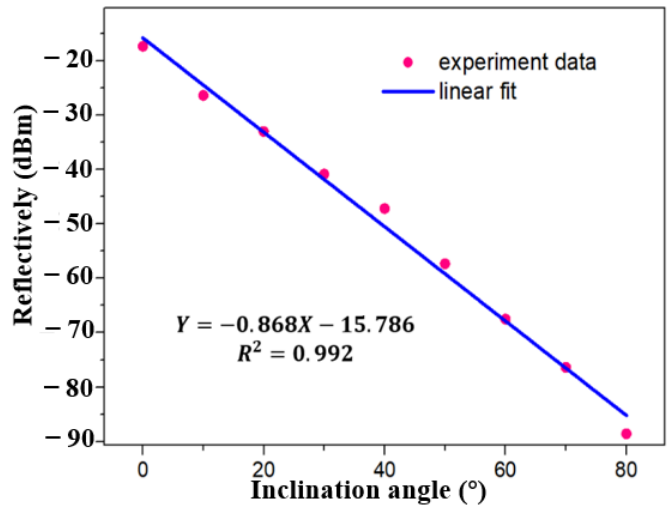
Figure 9. The dependence of the reflection spectrum at the wavelength of the reflection peak at different inclination angles in FRL with waist equals 86 µm.